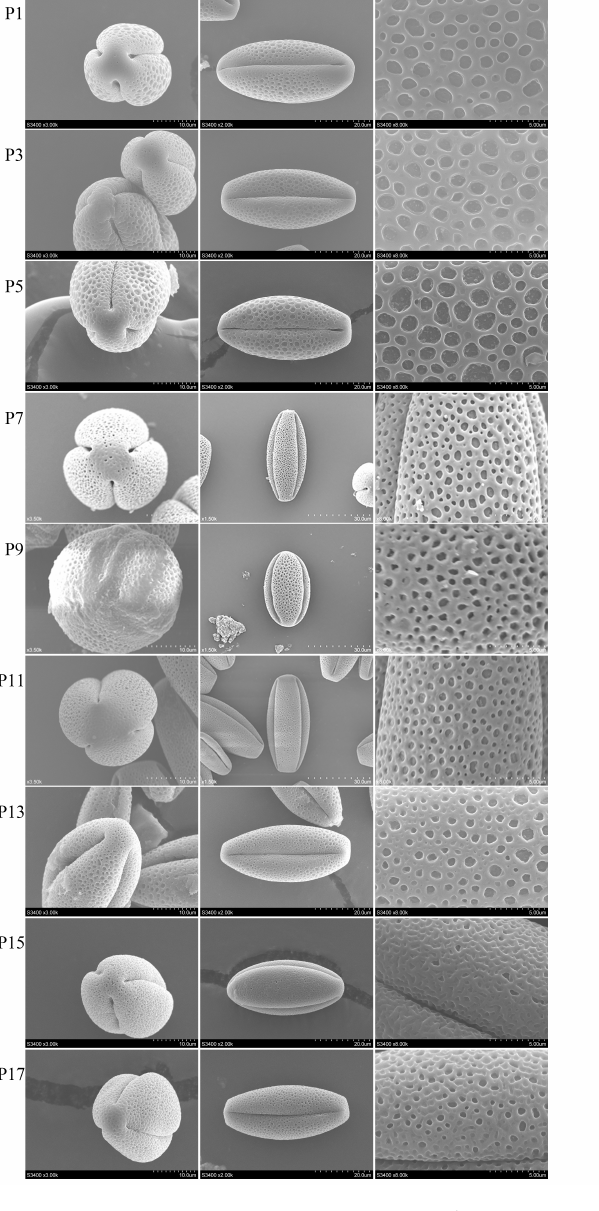
Figure 2. Scanning electron micrographs of pollen grains on 18 tree peony populations.